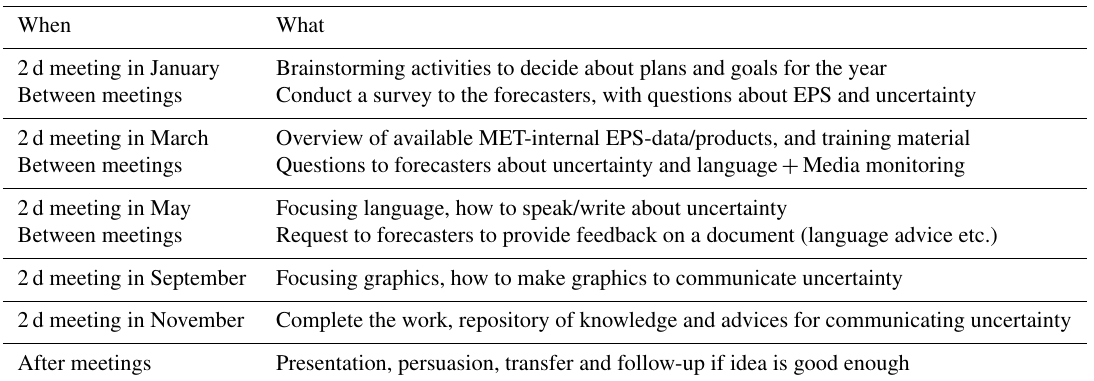
Table 1. Overview of the work process throughout the year. When What 2d meeting in January Brainstorming activities to decide about plans and goals for the